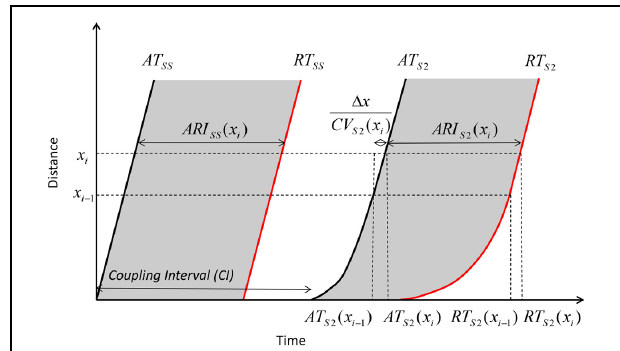
FIGURE 3 | Geometry relationship and derivation of modulation of dispersion. A premature extrastimulus results in conduction velocity restitution. Consequently, ATs are delayed, but this delay allows resumption toward steady state conduction velocities over the course of the activation path. The modulation of activation dispersion is amplified via ARI restitution on the repolarization wavefront, and dispersion of repolarization increases further.